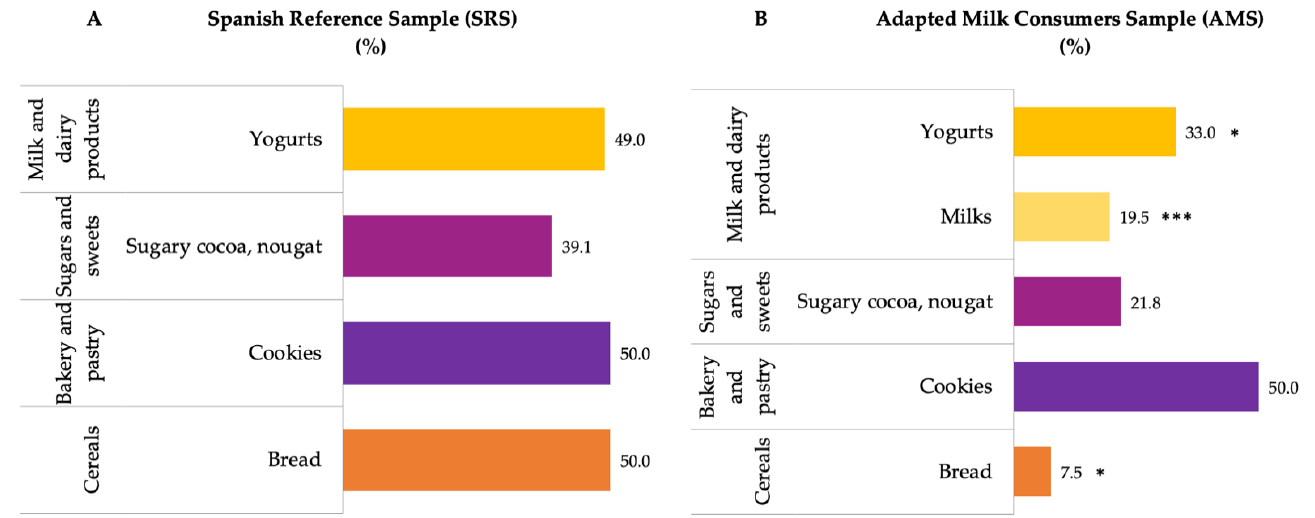
Figure 5. Bread and wheat flour, cookies, sugary cocoa, nougat, yogurts and milks subgroups contributing to added sugar intakes in the cereals, bakery and pastry, sugars and sweets, and milk and dairy products groups (%) from the EsNuPI study population (“Spanish Pediatric Population”) in both the Spanish Reference Sample ( A ) and the Adapted Milk Consumers Sample ( B ). * p ≤ 0.05 compared to reference sample (Mann–Whitney test). *** p ≤ 0.001 compared to reference sample (Mann–Whitney test).